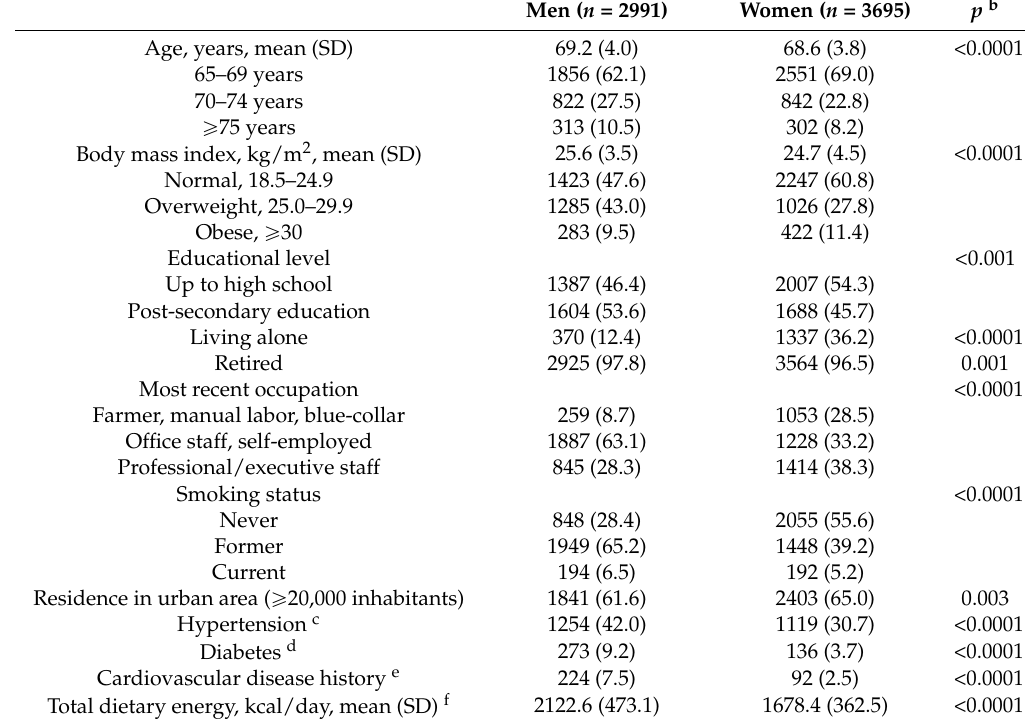
Table 2. Baseline characteristics of participants aged ě 65 years (Etude NutriNet-Santé, n = 6686) a